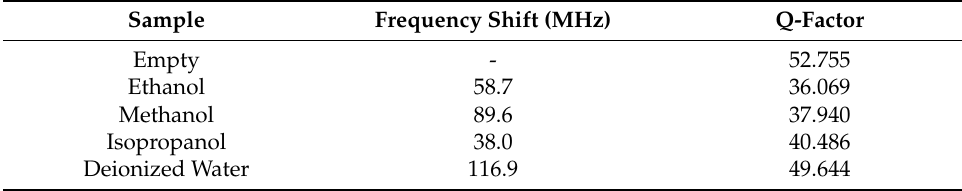
Table 3. The resonant frequency and Q-factor of different liquid